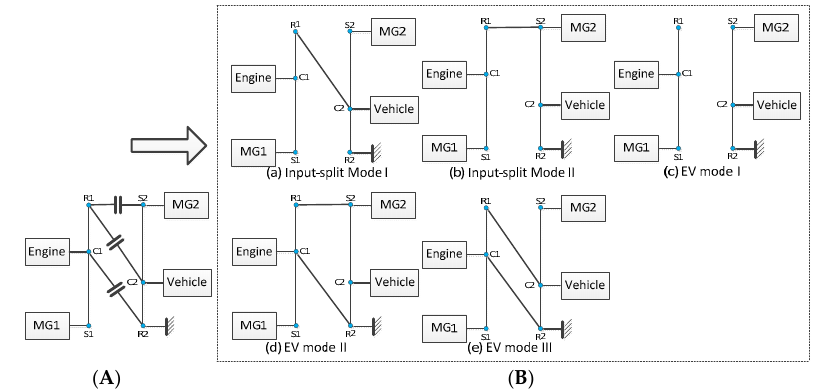
Figure 12. Identified optimal powertrain design for the target bus application and its operating modes